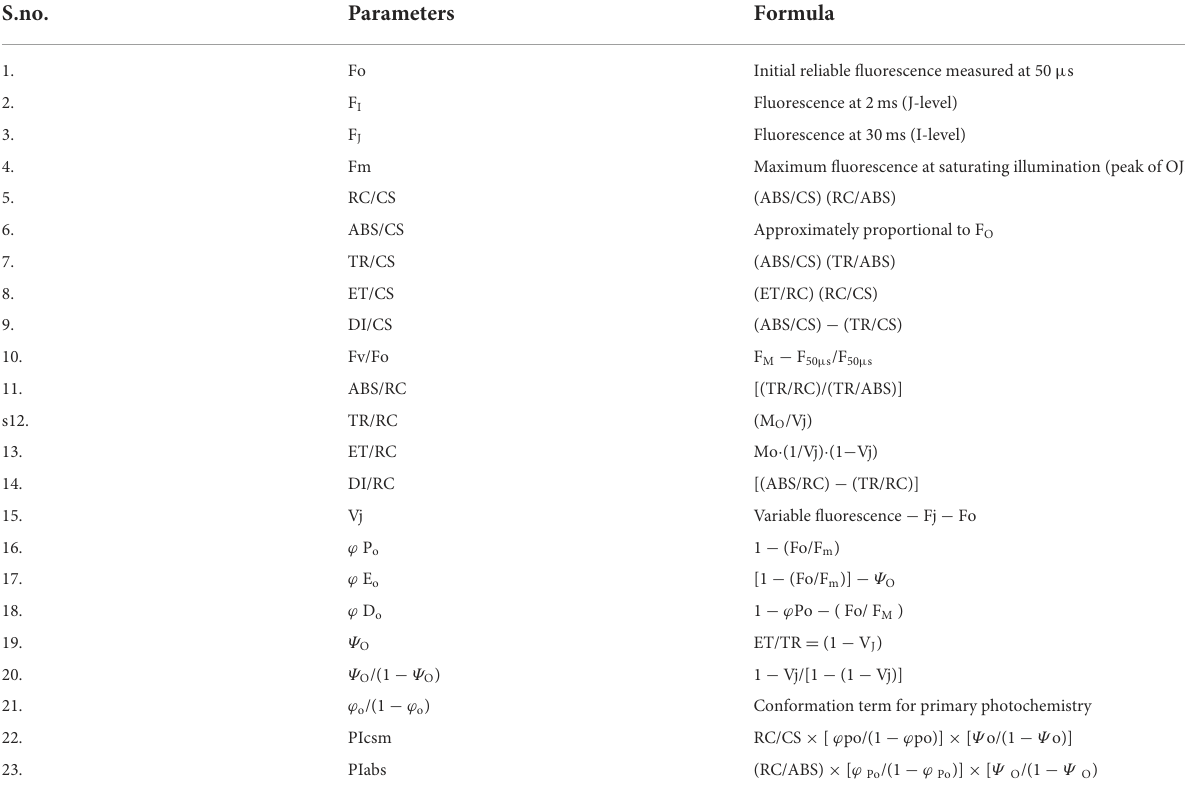
TABLE 1 Chlorophyll fluorescence parameters were analyzed in the present study. S.no.